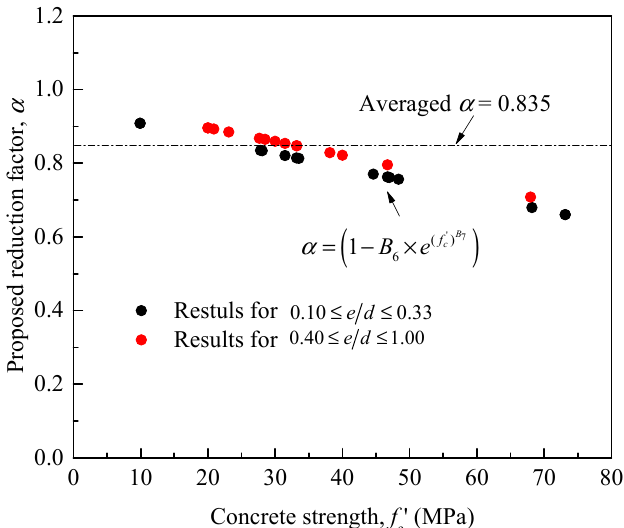
Figure 10. Relationship between the calculated reduction factor, α , and the unconfined concrete compression strength for the unconfined RC specimens summarized in Table 2.